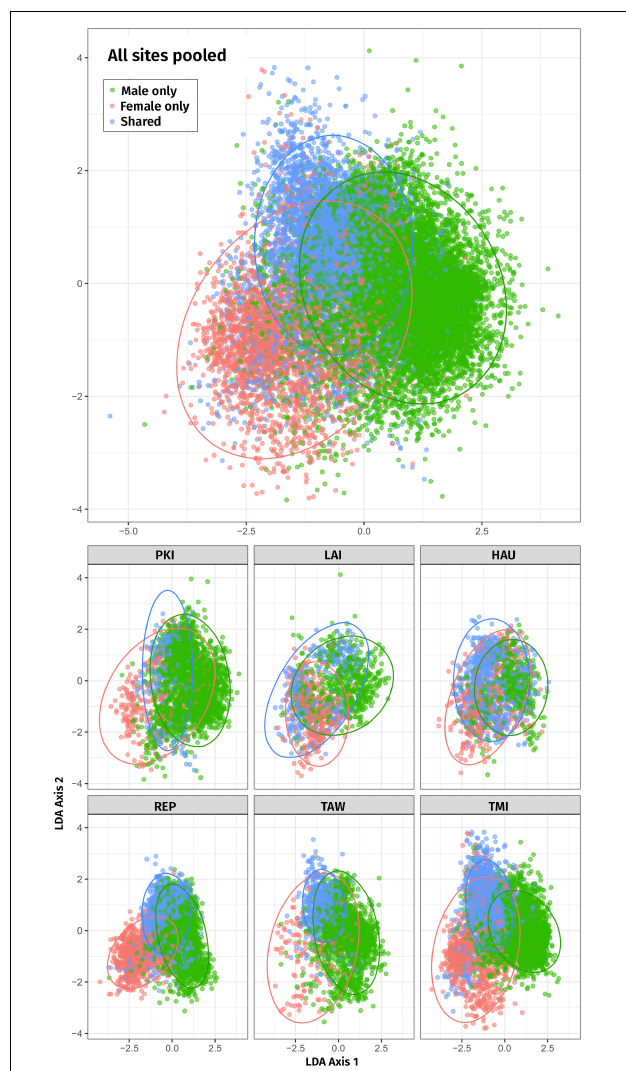
FIGURE 3 | Two-dimensional linear discriminant analysis (LDA) of male-only, female-only, and shared syllables for all sites combined (top) and each site separately (bottom) . Ellipses represent the regions covering 95% of the data (according to the fitted normal). Each site is plotted using the same axes to be comparable. Site abbreviations are as follows: PKI, Tawhiti Rahi, representing Poor Knights Islands; LAI, Lady Alice Island, representing Hen & Chickens; HAU, Hauturu; REP, Repanga; TAW, Tawharanui; TMI,